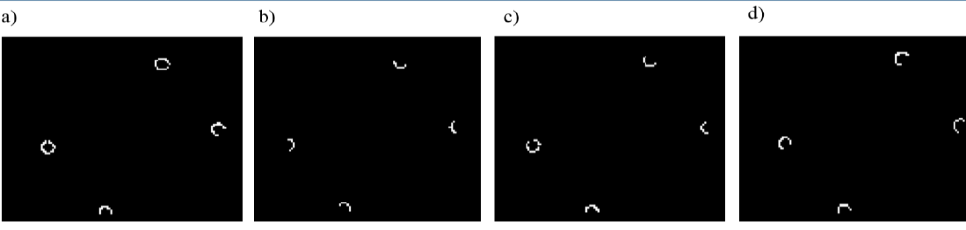
Figure 9. The same binarized area is shown for the experiments ( a ), ( b ), ( c ) and ( d ) (Figure 8) of the round cross-section case